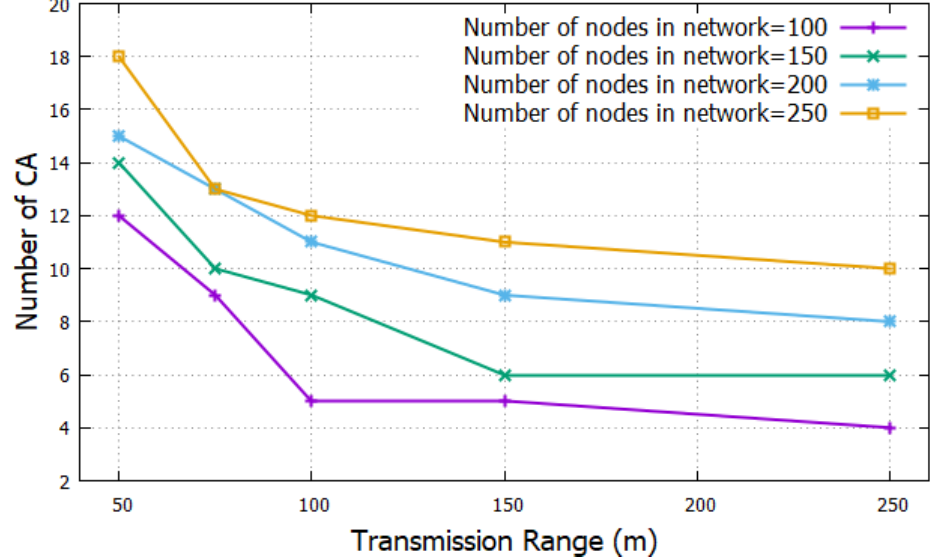
Figure 2. The number of CA as a function of the number of sensor nodes in the network.